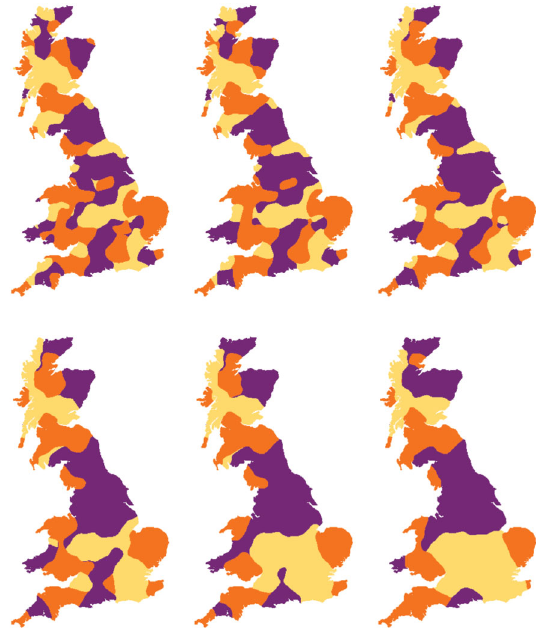
FIG. 2. Evolution of the V ¼ 3 model from randomized initial condition with σ ¼ 15 km and β ¼ 1 . 1 at times t ∈ f 1 ; 2 ; 4 ; 8 ; 16 ; 32 g , where one time unit corresponds to one memory length. Colors indicate which variant is most common at each position. Numerical solution implemented in C ++ on grid with 2-km spacing [63] (GB is ≈ 1000 km north to south). Each grid point initialized with randomly selected variant.